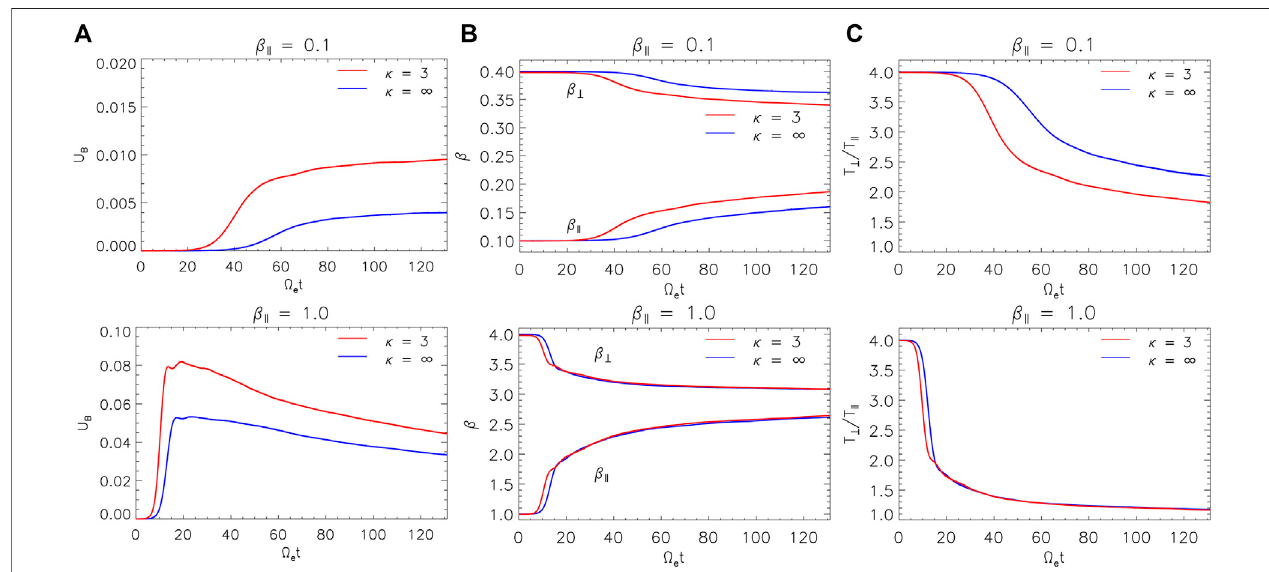
FIGURE 3 | Temporal variation of whistler instability from PIC simulations for bi-Kappa (red) and bi-Maxwellian electrons (blue): magnetic fi eld power (A) , plasma betas (B) and temperature anisotropy (C) . Initial parameters are A e (0) (cid:1) 4.0, β e, (cid:3) (0) (cid:1) 0.1 (top) and β e, (cid:3) (0) (cid:1) 1.0 (bottom) .